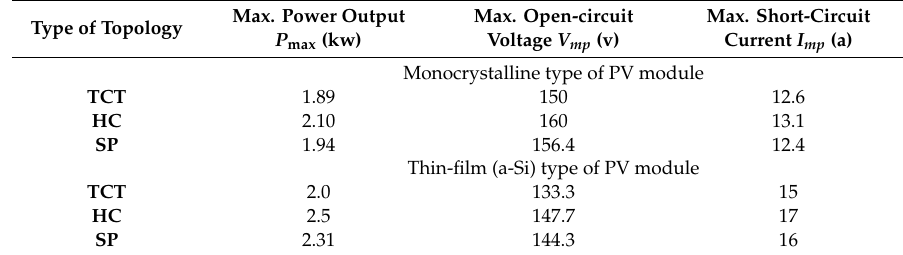
Table 9. Parameters of the PV model for multiple faults (F4).